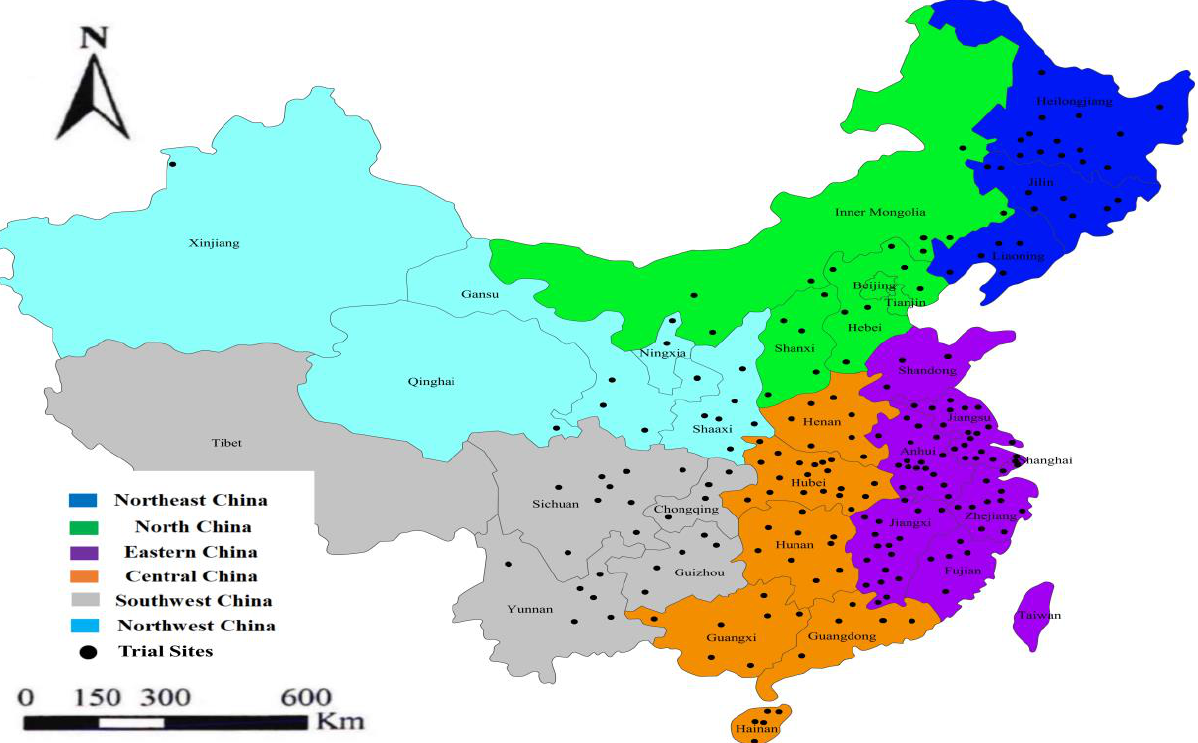
Figure 1. Geographical regions of rice cultivation in China and the distribution of rice-field trial sites identified in the papers that met the inclusion criteria.